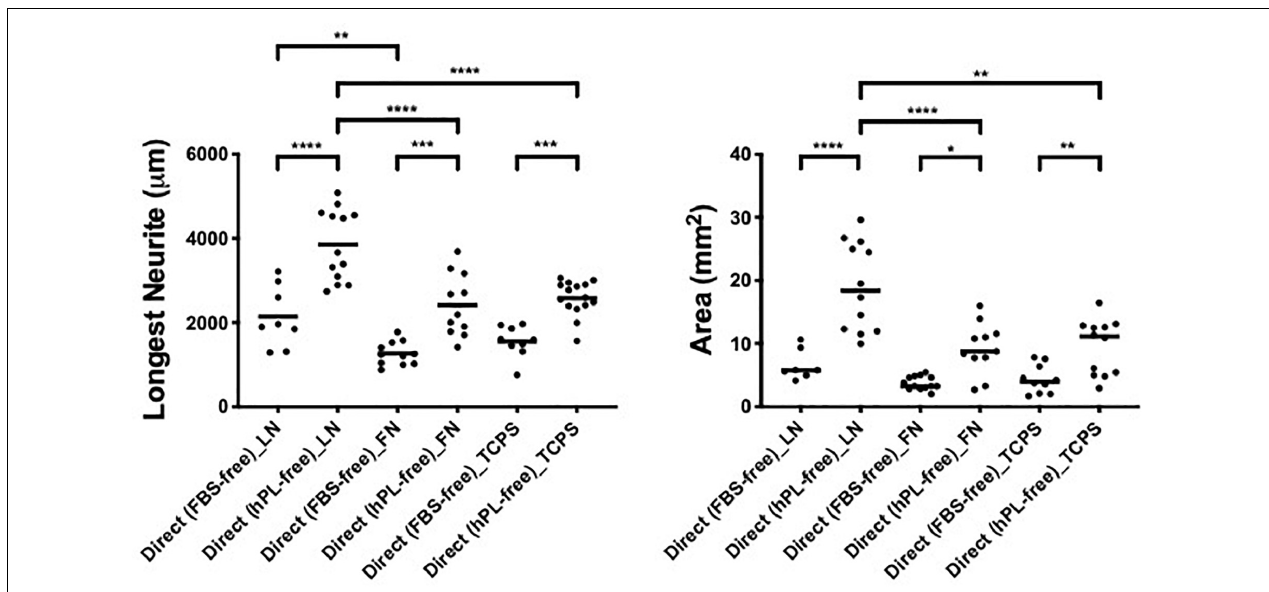
FIGURE 3 | ECM, human adipose-derived stem cells (hADSC), and human platelet lysate (hPL) synergistically interact enhancing DRG outgrowth (condition 2—direct co-culture). Longest neurite and axonal area of direct co-culture on ECM. Three biological repeats and at least three technical replicates (DRG) were assessed. One-way ANOVA with Tukey’s multiple comparison tests was used for assessing statistical significance among the examined groups (* p < 0.05, ** p < 0.01, *** p < 0.001, **** p < 0.0001). The number of DRG tested corresponds to the number of dots for each condition in the